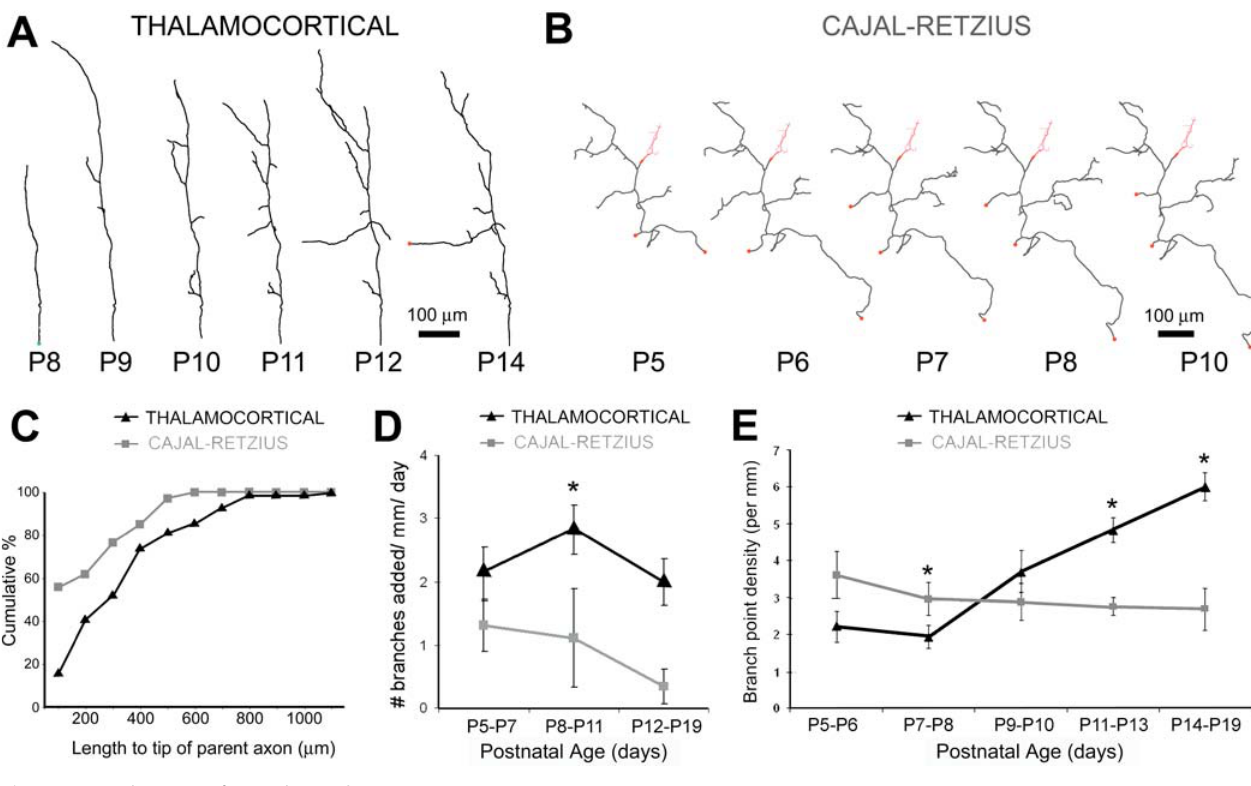
Figure 7. Development of Axonal Complexity (A) Tracings of a representative TC axon from P8 to P14. (B) Tracings of a representative CR axon from P5 to P10. (C) Location of branch additions with respect to tip of parent axon for 69 new TC branches and 34 new CR branches. The difference between TC and CR axons was significant ( p , 0.05). (D) The rate of branch additions per millimeter of axon per day was greater in TC axons ( n ¼ 30) than in CR axons ( n ¼ 12). Error bars represent SEM. * The difference was significant at P8–P11 ( p ,